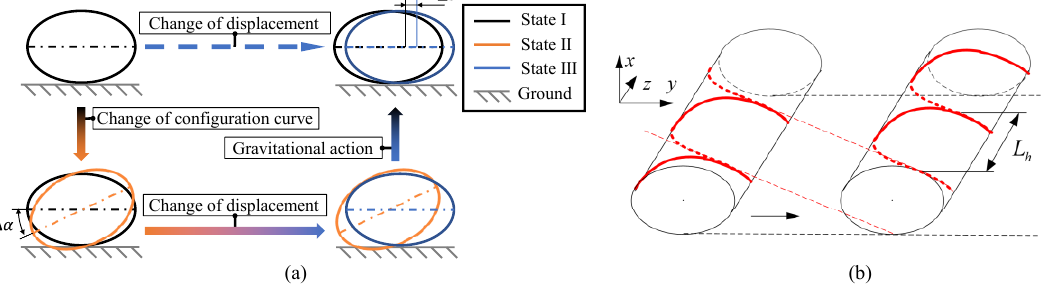
Figure 8. AEH-sidewiding gait movement principle. ( a ) Schematic diagram of movement principle. The state I represents a stable state in equilibrium under the action of gravity, and state II shows the shape after configuration change, and state III is the stable state after the configuration changes and moves under the action of gravity. The space movement of the snake robot is realized by changing the configuration state in a cycle. ( b ) Schematic diagram of motion results of snake robot adopting AEH-sidewinding gait.